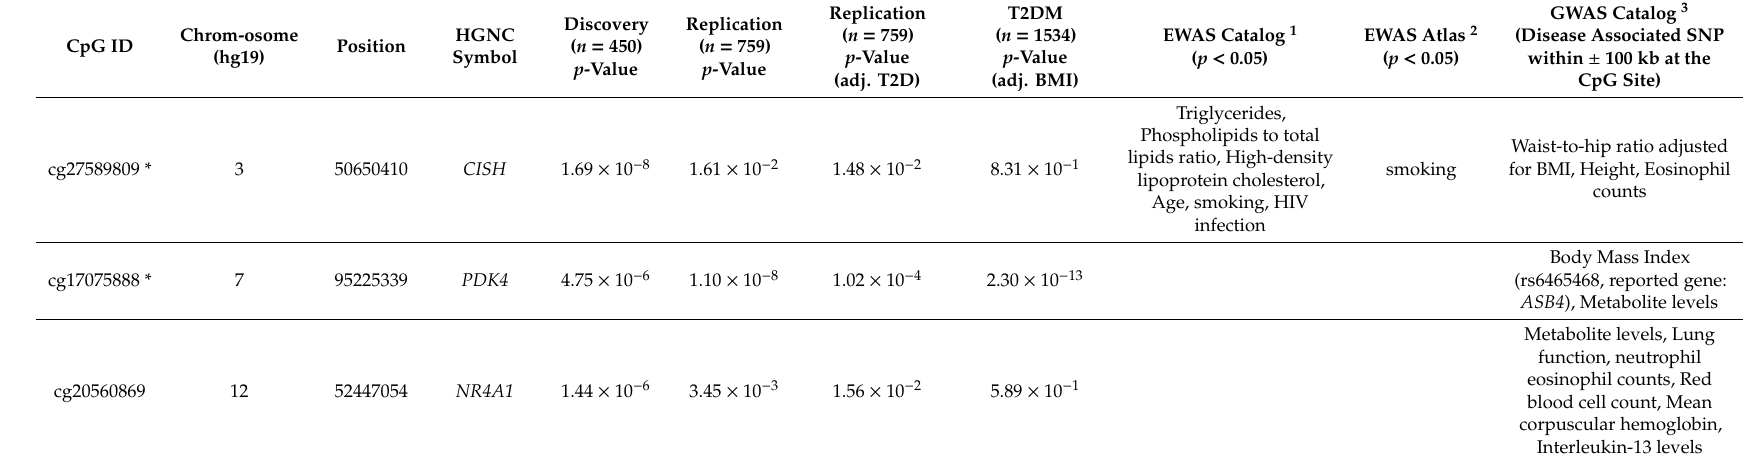
Table 2. Obesity-associated methylation markers newly identified in the current